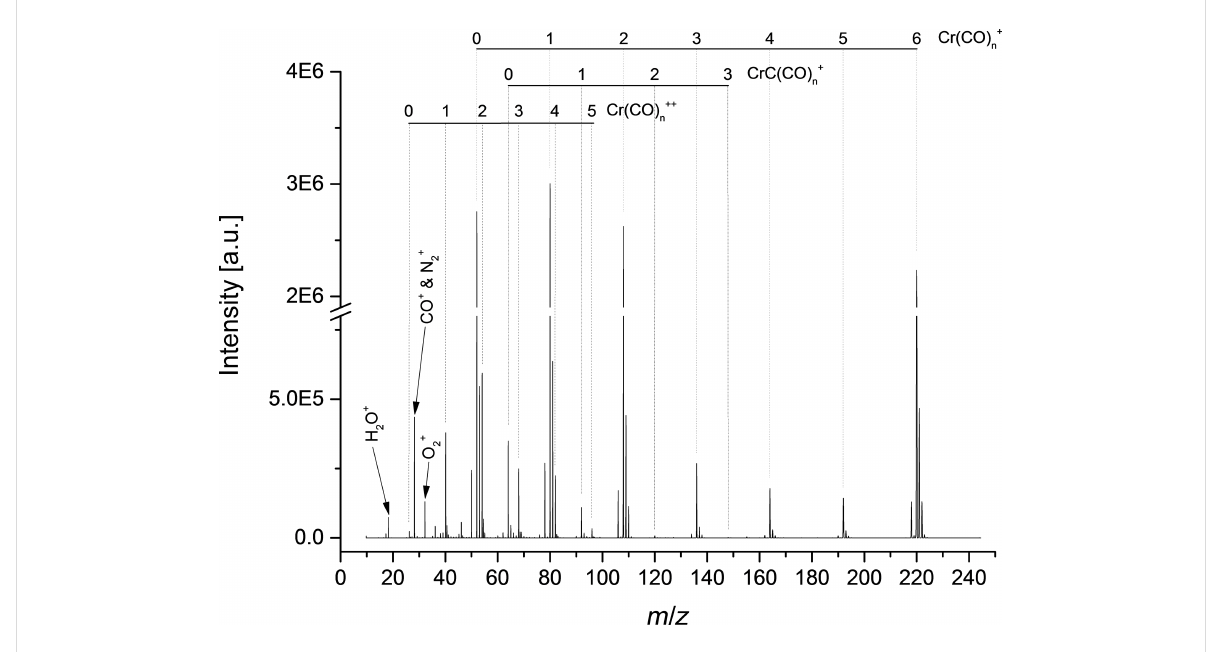
Figure 3: Electron ionization mass spectrum of Cr(CO) 6 obtained at an electron energy of ca. 70 eV.